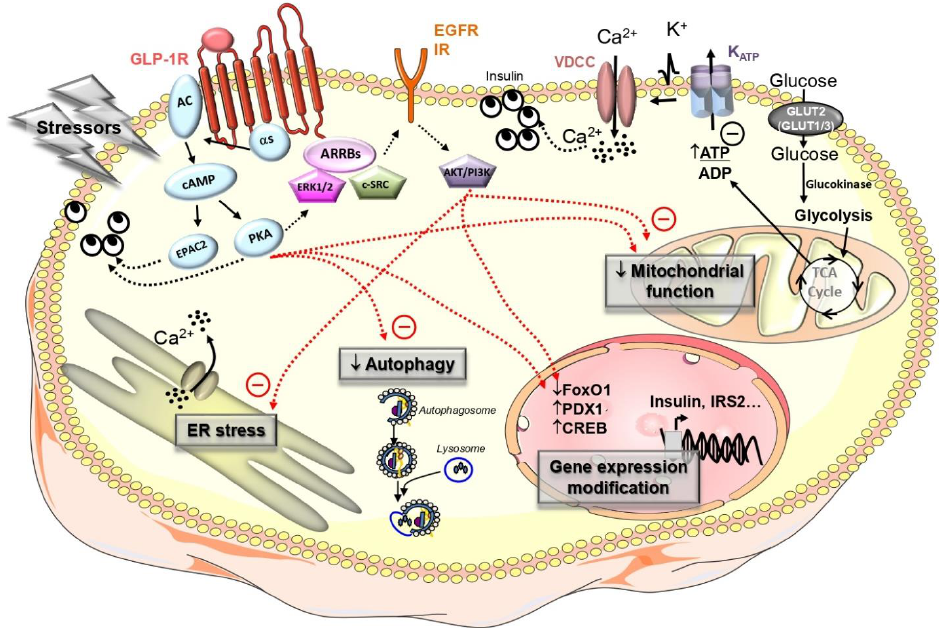
Figure 2. Main molecular mechanisms induced by glucagon-like peptide-1 (GLP-1) to protect beta-cells from apoptosis. Beta-cell stressors (such as increased IAPP, gluco- and/or lipotoxicity) may trigger ER stress, alter mitochondrial function and/or the autophagic flux and modify gene expression. GLP-1 and GLP-1RA have been reported to protect beta-cells by alleviating these deleterious effects.